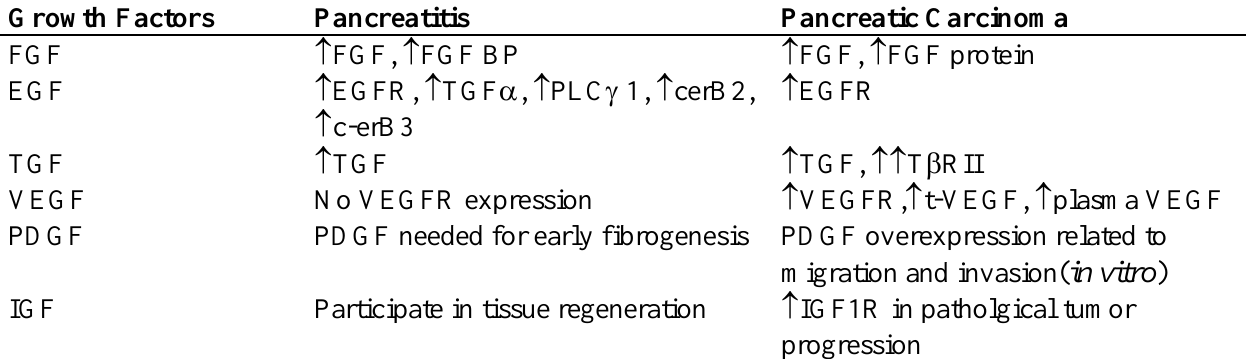
Table 2. Variability of growth factor expression in pancreatitis versus pancreatic carcinoma.